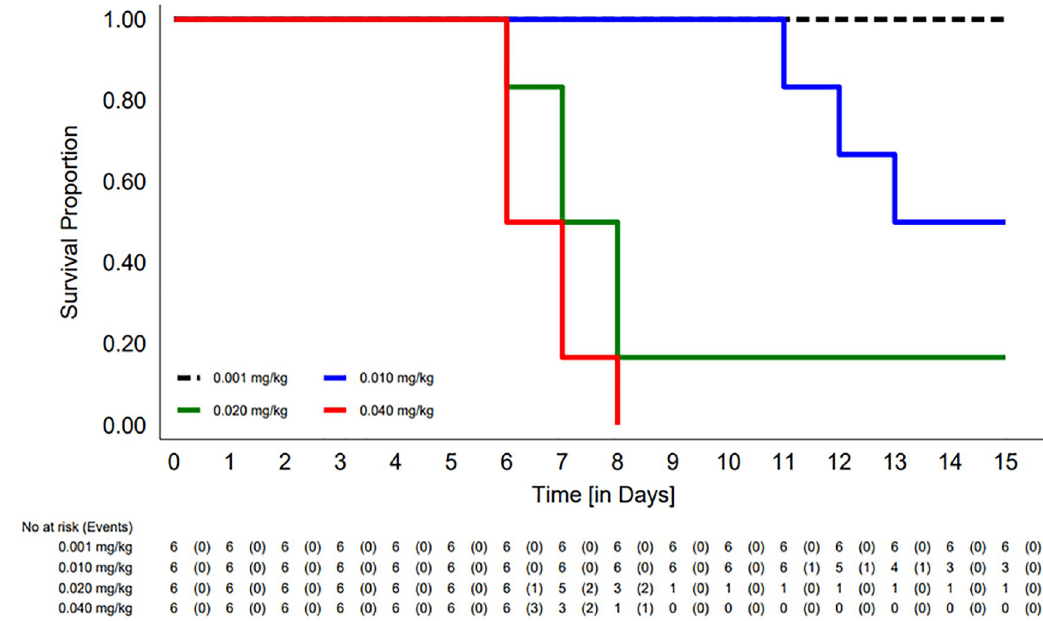
Fig 4. Plot of Kaplan-Meier survival analysis (survival curve) for four groups of guinea pigs after Transitmycin administration is depicted. In this study, the outcome event of mortality after third dose of drug was observed at concentrations with median survival time 0.01mg/kg 13[12-15days], 0.02mg/kg 7[7-8days] and 0.04mg/kg 6[6-7days] respectively. Further, all the animals survived at 0.001mg/kg (n = 6/6) concentration for 15